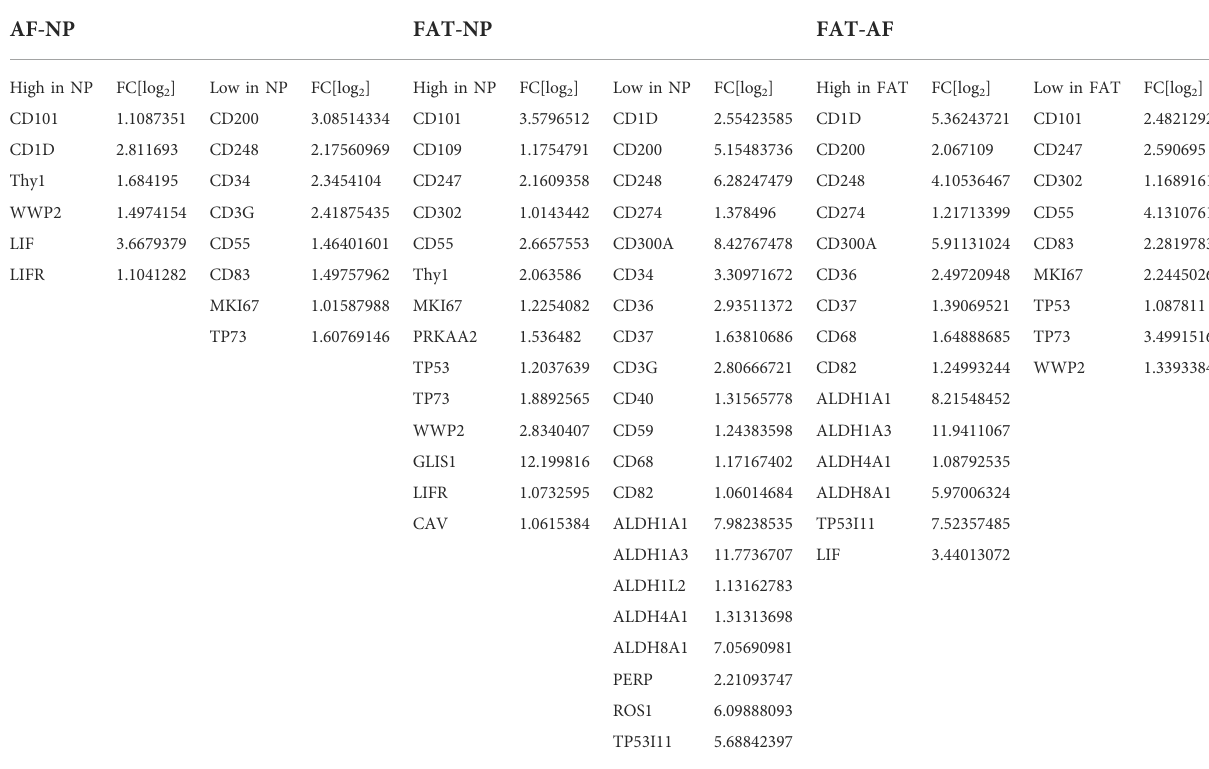
TABLE 5 Differentially expressed genes related to cell proliferation and differentiation between annulus fi brosus (AF) and nucleus pulposus(NP) cells of the IVD and adipose (FAT) stromal cells of the same donor displayed by the log 2 fold changes (FC[log 2 ]). Cluster of differentiation, proliferation, and tumor markers